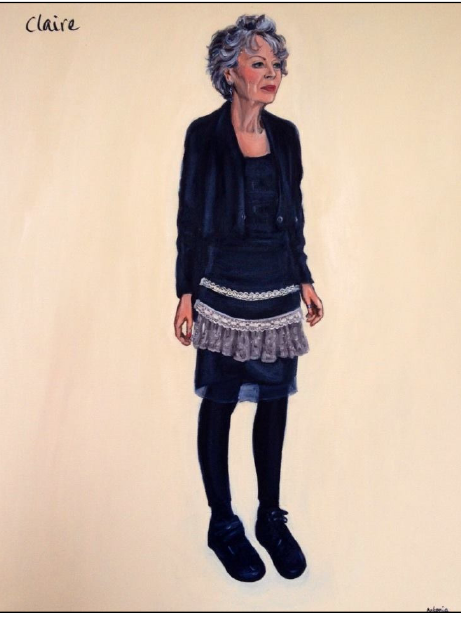
Figure 8. Claire